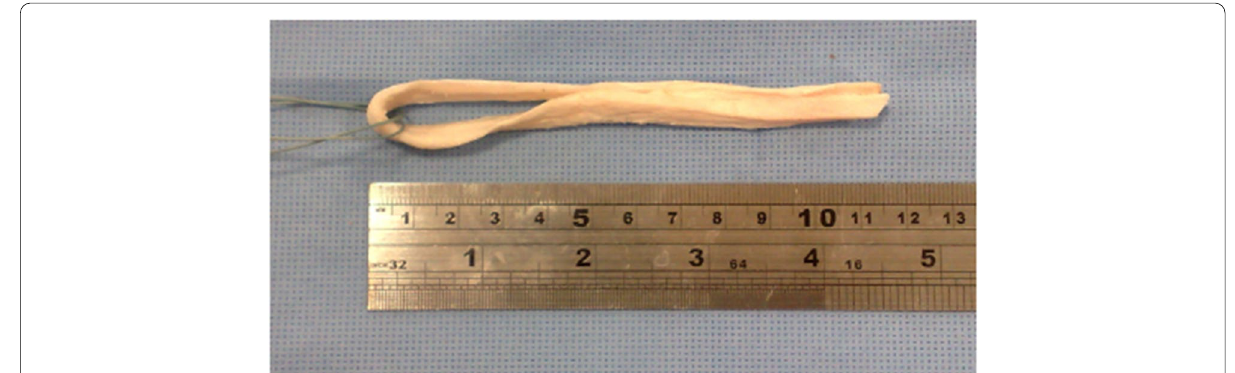
Fig. 3 A typical looped bovine tendon sample is used as a soft tissue graft for experiments